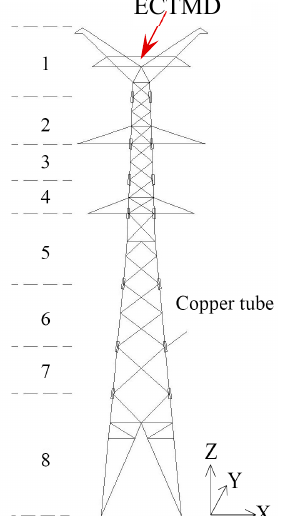
Figure 8. Diagram of aeroelastic tower model.